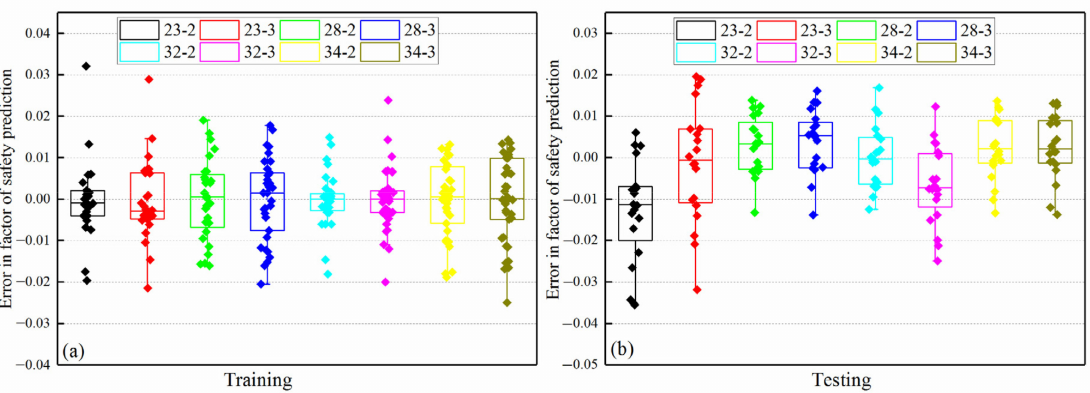
Figure 11. The error in factors of safety prediction obtained from WOA-GPR with different samples and cycles (here 23-2 denotes two cycles with 32 samples): ( a ) Training; ( b )